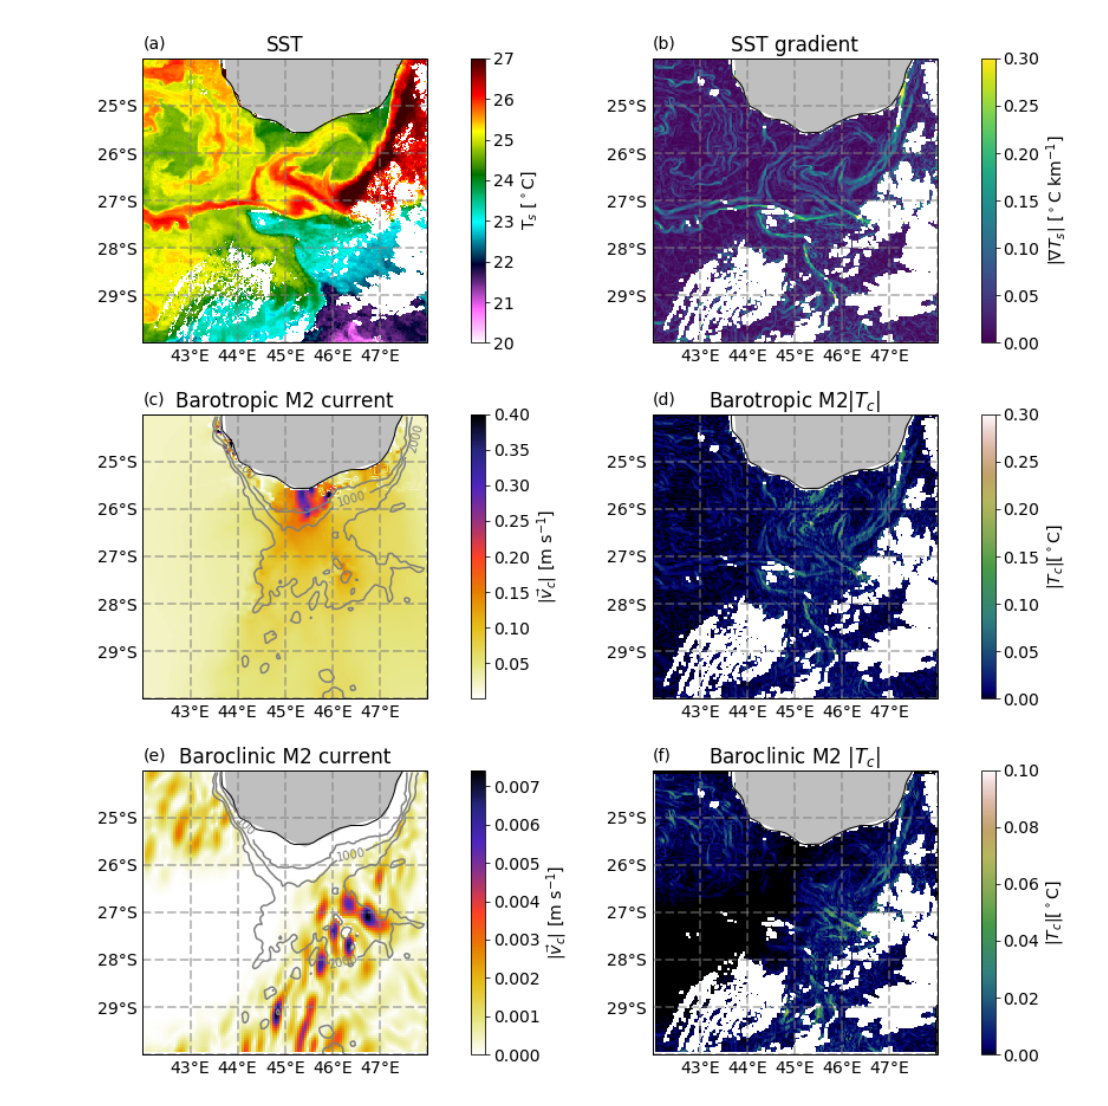
Figure 4. ( a ) SST captured by METOP on the 5 June 2014. ( b ) Sobel gradient of SST. ( c ) M2 barotropic FES amplitude current. Gray contour correspond to the bathymetry. ( d ) Estimation of the amplitude of M2 barotropic signature on SST. ( e ) M2 baroclinic HRET amplitude current for areas with a bathymetry deeper than 1000m. Gray contour lines correspond to the bathymetry. ( f ) Estimation of the amplitude of M2 IW signature on